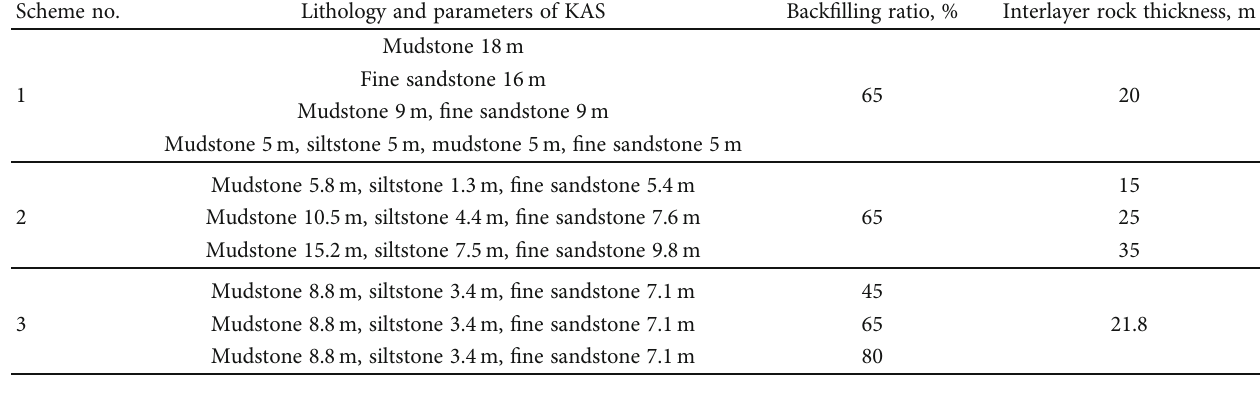
Table 2: Numerical simulation schemes and parameters.